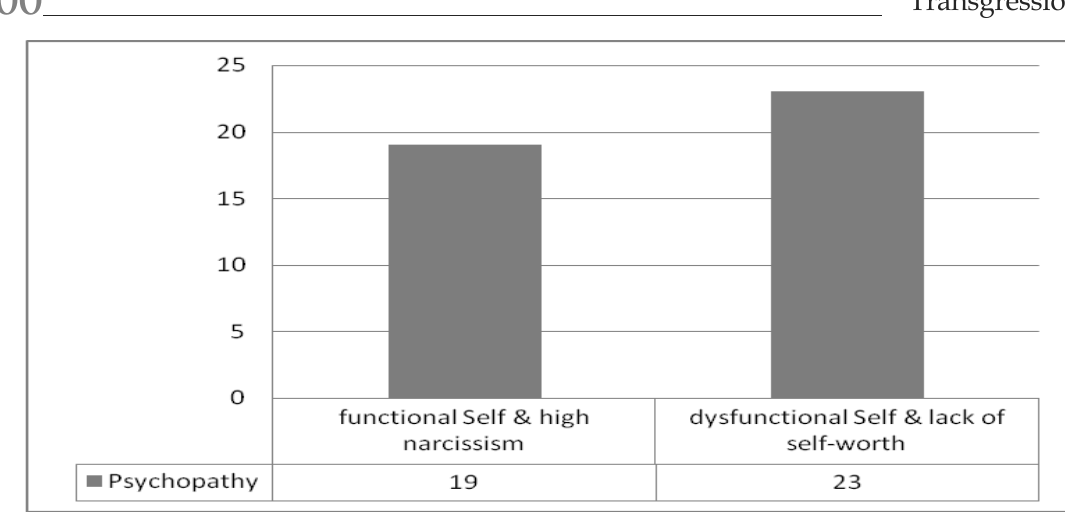
Figure 5. The propensity for Psychopathy, depending on the type of narcissistic